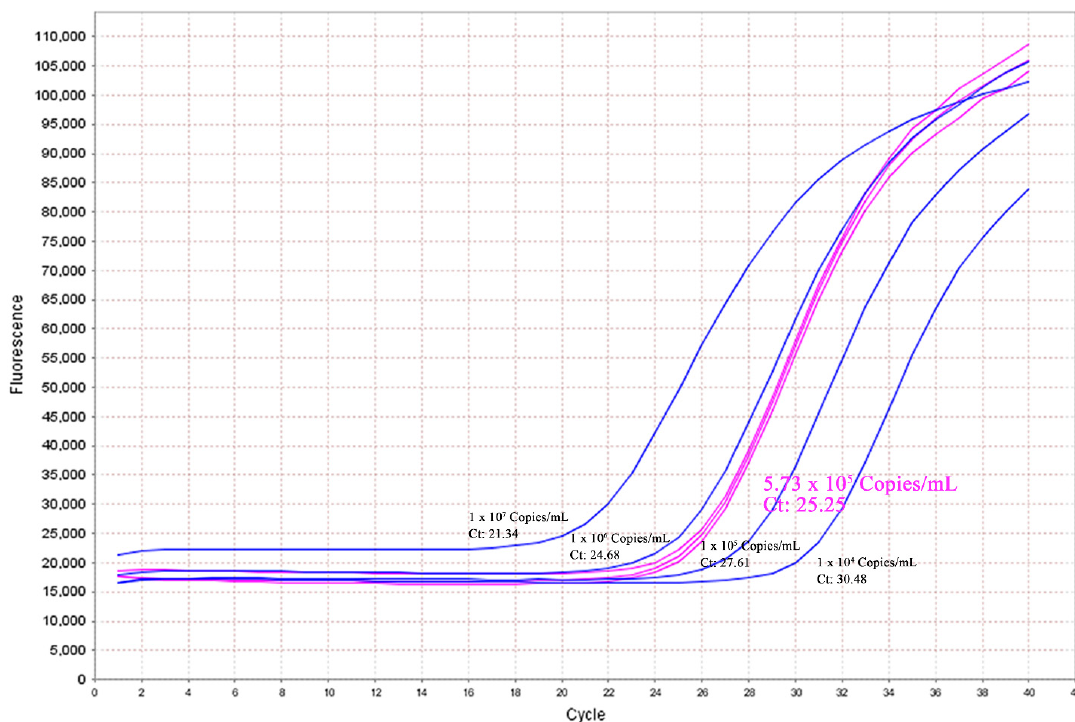
Figure 4. RT-PCR validation of the viral DNA in the amniotic fluid. The load of cytomegalovirus (CMV) was 5.73 × 10 5 copies/mL, which indicated intrauterine CMV infection in case 5. 5.73 × 10 5 copies/mL, which indicated intrauterine CMV infection in case